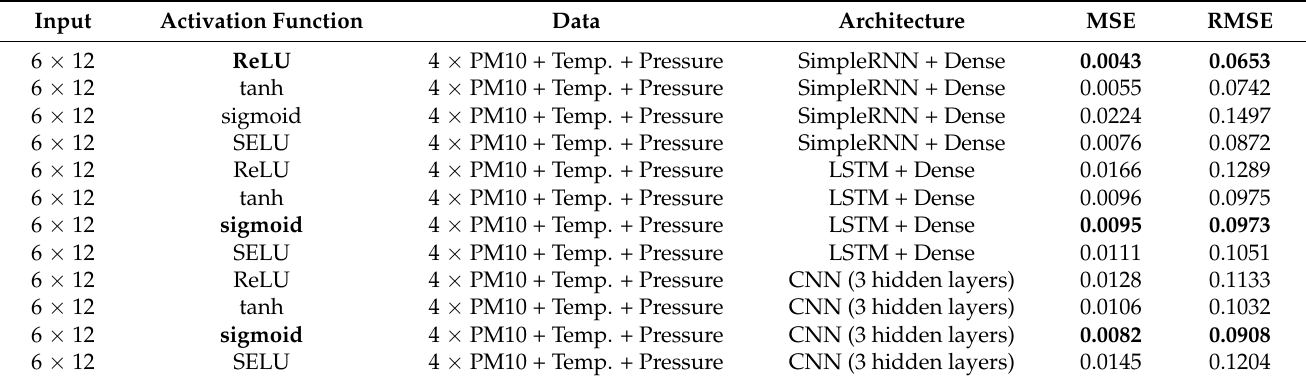
Table 3. Comparison among different activation functions with the achieved average forecasting performance in terms of Mean Squared Error (MSE) and Root Mean Squared Error (RMSE) for the +6 h time horizon. SELU, Scaled Exponential Linear Unit. The best performance is marked in bold.